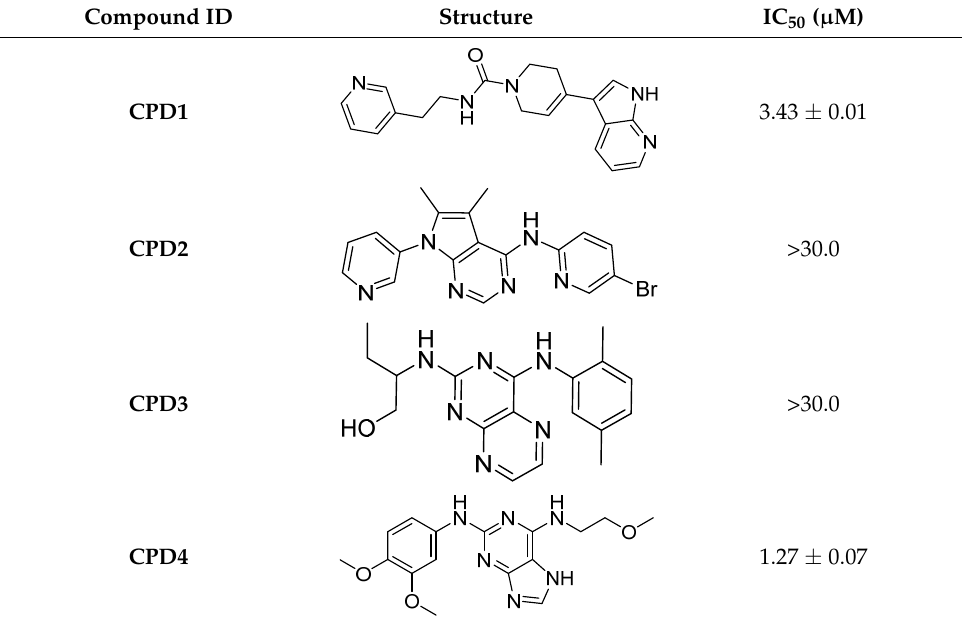
Table 2. Structure and Cdk5 inhibition activity of the tested compounds.